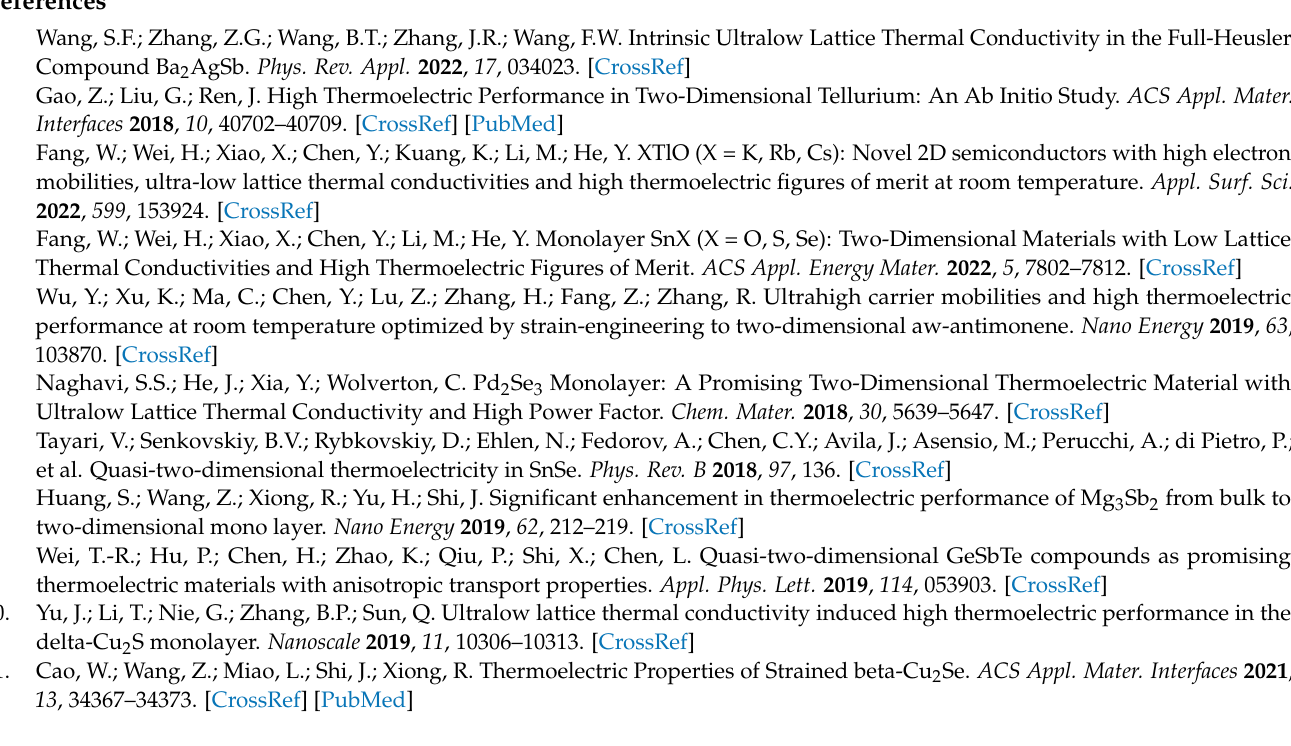
Electron Localization Functions, Figure S2: the ab initio molecules dynamics simulation, Table S2: Bader charge analysis results, Figure S3: the band structures at PBE functional without and with SOC functional, Figure S4: the partial density of states, Figure S5, Table S3, Figure S6: the details on carrier mobility calculations, Figure S7: the MLWFs calculated by Wannnier90 code, Figures S8 and S9: